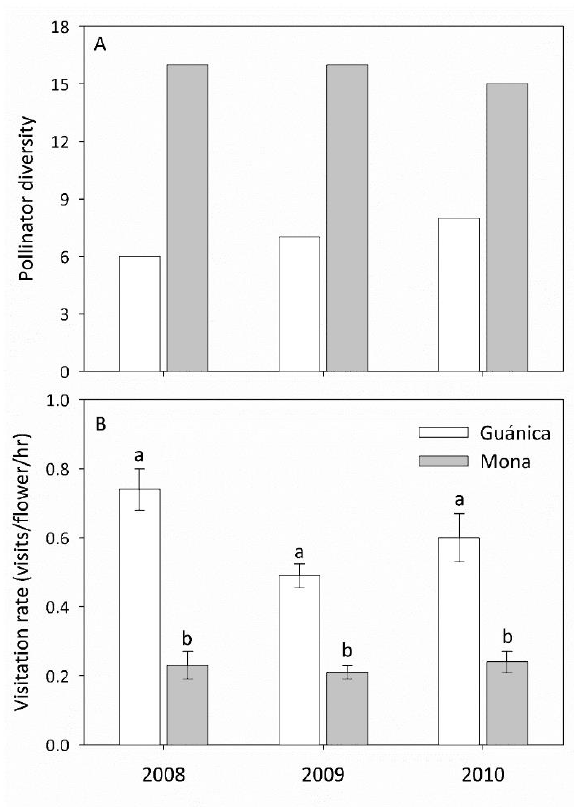
Figure 3. Pollinator diversity (A) and flower visitation rates (B) across years for Guánica and Mona Island. Error bars are standard error of the mean. Different letters indicate significant differences (Tukey’s post hoc tests, P < 0.05) between islands.